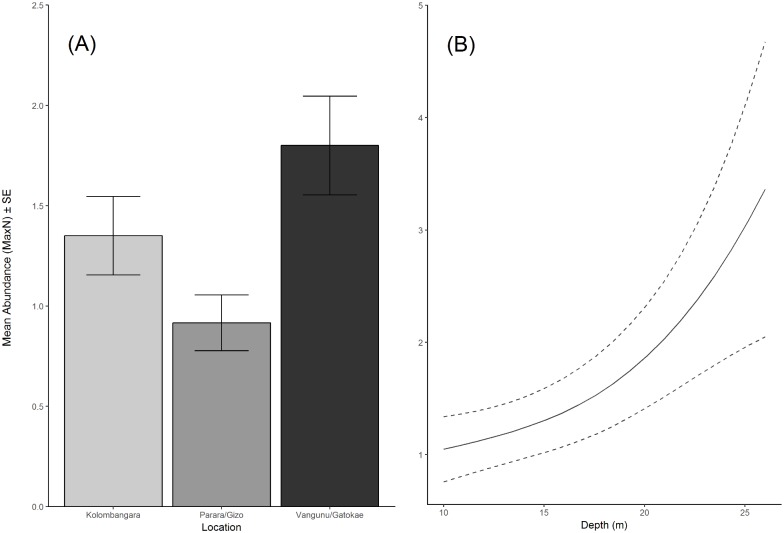
(a) The mean abundance of reef sharks per 60 minute replicate (MaxN) across locations and (b) The abundance of reef sharks (MaxN) across depth.Solid lines are fitted gam curves, with dashed lines indicating standard error confidence bands.